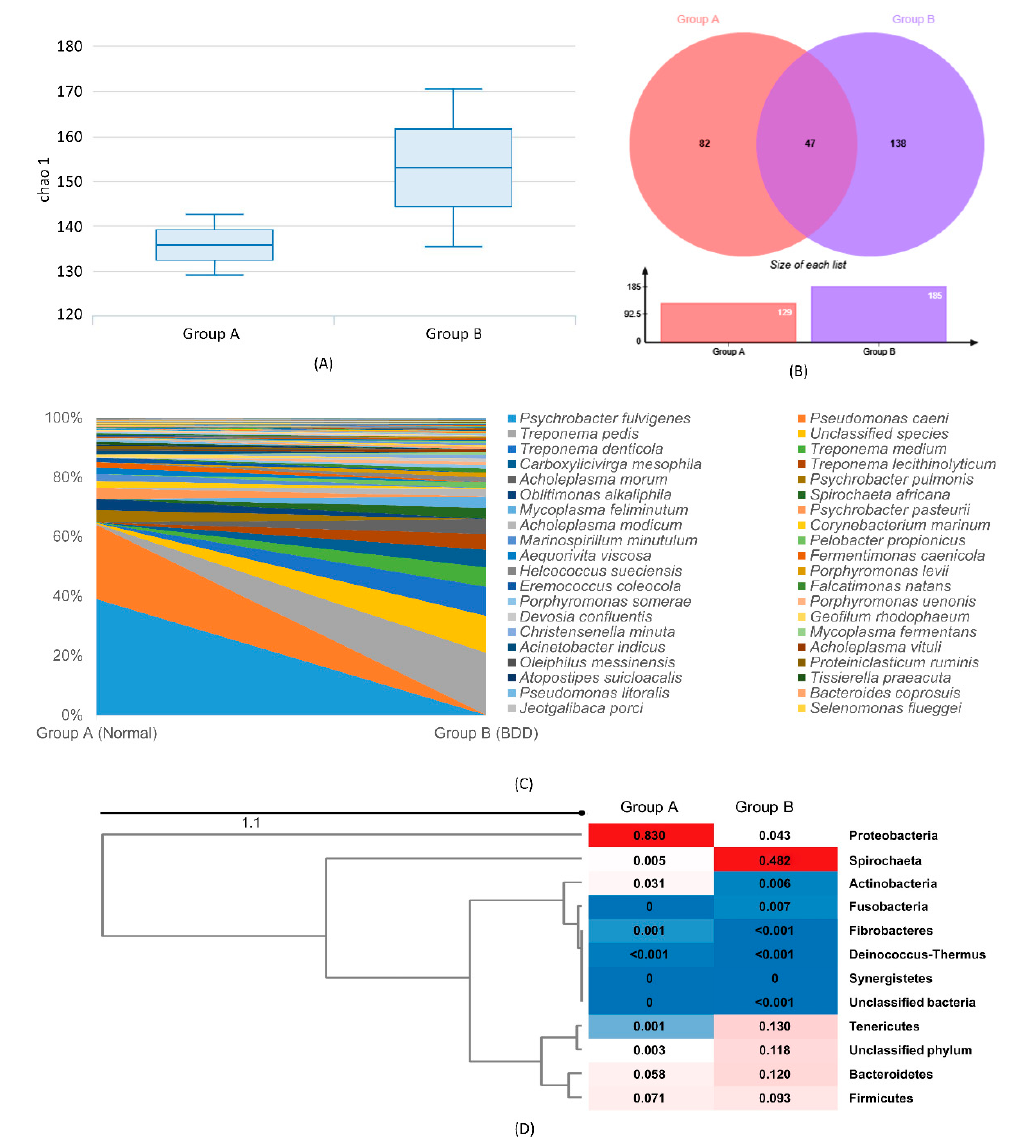
Figure 1. ( A ) Box plot of Chao1 diversity index for bovine digital dermatitis (BDD) (Group A) and normal (Group B), ( B ) the microbiome presenting the number of operational taxonomic units (OTUs) in Group A and Group B showing the unique and shared OTUs between groups, and ( C ) relative abundance of operational taxonomic units from Group A and Group B (legend: 22 most abundant). ( D ) Euclidian distance heatmap presenting the association between phylum and sample groups. Red denotes closer association while blue denotes a lesser association with normal sample and BDD.